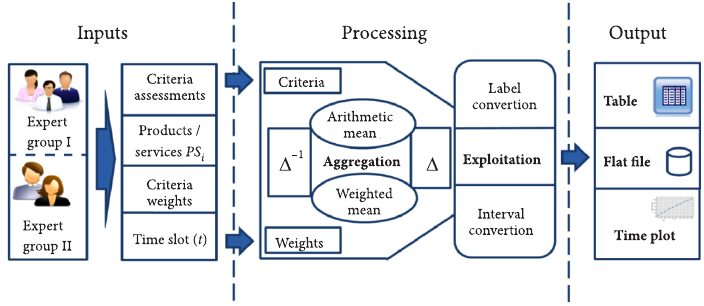
Figure 2. Diagram of the multi-criteria model proposed for scheduling the launch of products/services according to a strategic